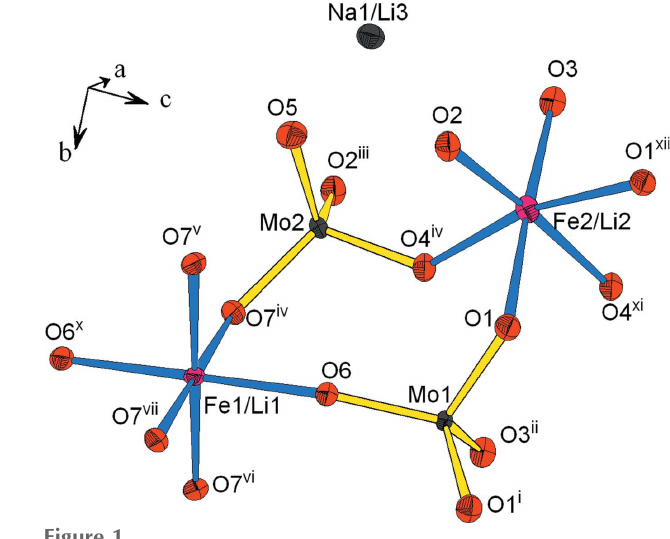
Figure 1 Repre´sentation des polye`dres de coordination de l’unite´ structurale dans le compose´ (Na 0,4 ,Li 0,6 )(Fe,Li 2 )(MoO 4 ) 3 . [Codes de syme´trie: (i) x , (cid:2) y + 3 z ; (ii) x , y , z + 1; (iii) x + 1, y , z ; (iv) x , y + 1, z ; (v) x (cid:2) 1 x (cid:2) 1 , y , (cid:2) z + 1 ; (vii) x (cid:2) 1, y , z ; (x) (cid:2) x + 1, (cid:2) y + 1, (cid:2) z + 1; (xi) (cid:2) x + 1, 2 2 (cid:2) y + 1, (cid:2) z ; (xii) x (cid:2) 1, y , z (cid:2)